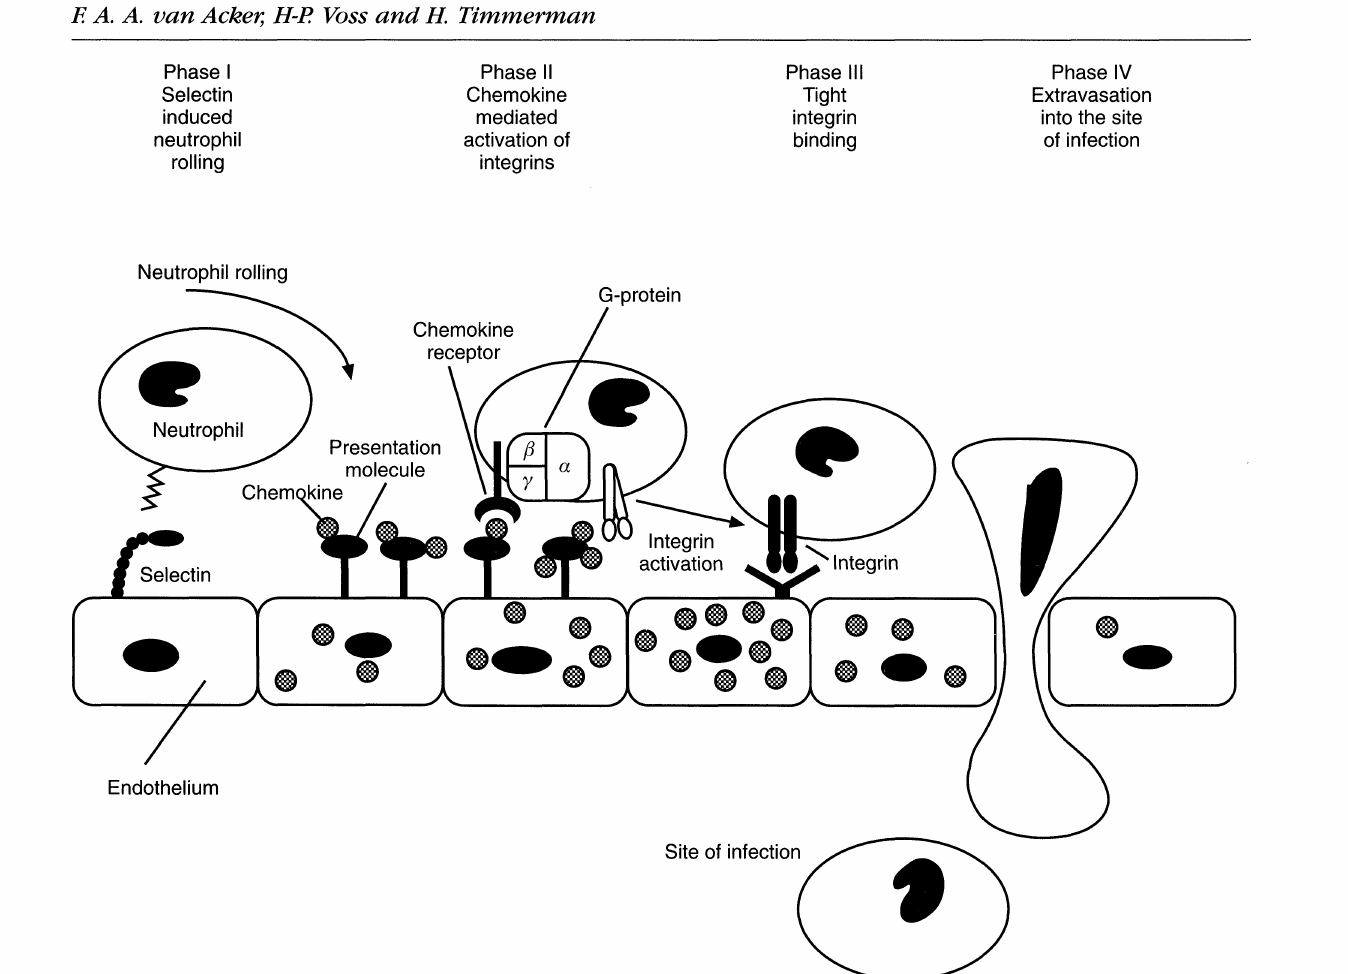
FIG. 5. A hypothetical, multistep model of the extravasation of specific leukocyte subsets near a site of infection. The sequential steps provide the traffic signals that regulate leukocyte localization in the vasculature. Lymphokines produced in response to the pathogen induce changes in the epithelium, including the formation of a gradient of specific chemokines: the gradient may be generated by local production of the chemokines by endothelial cells and their electrostatic attachment to glycosaminoglycan carbohydrates on proteoglycans as CD44. 77’79